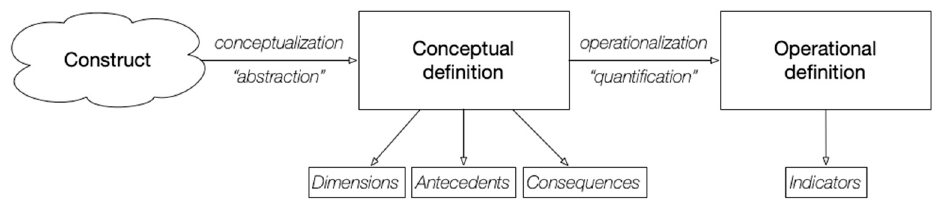
Figure 2. The two-step research process of defining model operational indicators of interorganizational fairness (IOF).